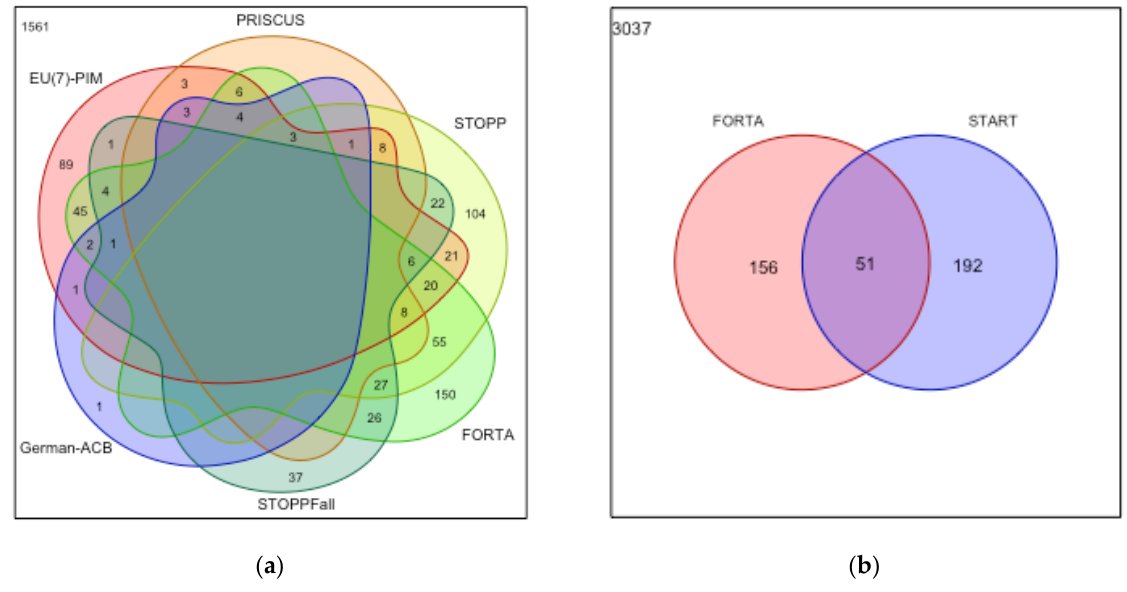
Figure 1. Venn diagrams of unique and overlapping detection of PIMs ( a ) and PPOs ( b ) by different tools. The numbers represent the quantities of PIMs/PPOs in that respective area (e.g., STOPP uniquely identified 104 PIMs, but 55 PIMs that STOPP detected were also detected by FORTA). Blank areas without numbers are to be interpreted as zero.